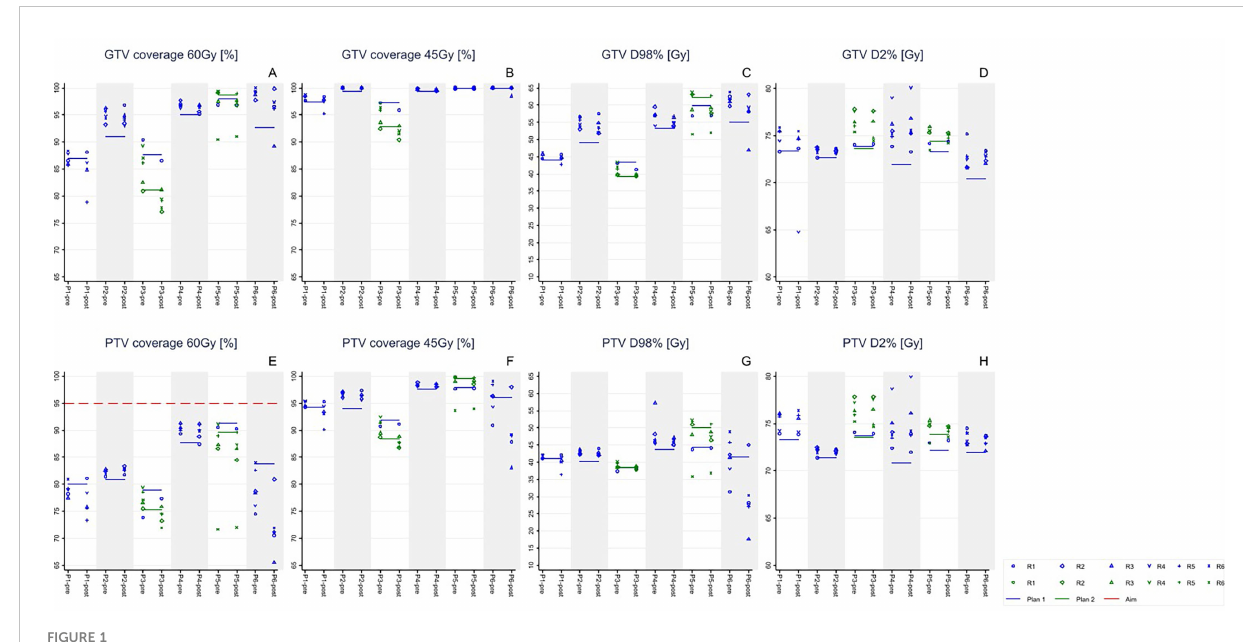
FIGURE 1 For all 6 study patients (P i , i=1..6), re-calculated GTV (upper panels A-D ) and PTV (lower panels E-H ) doses in pre- and post-rCTs (markers) compared to planning (horizontal lines). During the fractionated treatment, the initial treatment plan for patients 3 and 5 (plan 1, blue) was updated (plan 2, green). Rj (j=1,...6): rCT in the j-th fraction in which rCTs were acquired. Each panel describes an aim for the GTV and PTV as per STRONG study (see Table